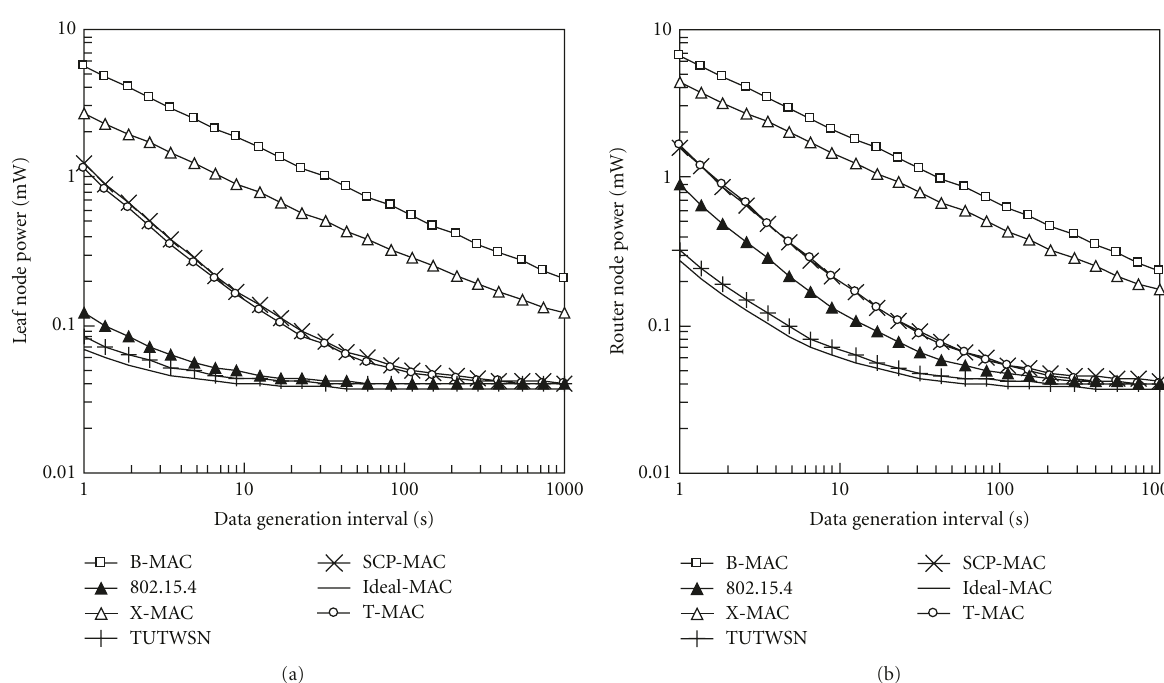
Figure 14: Power consumption comparison using the High Rate (HR)